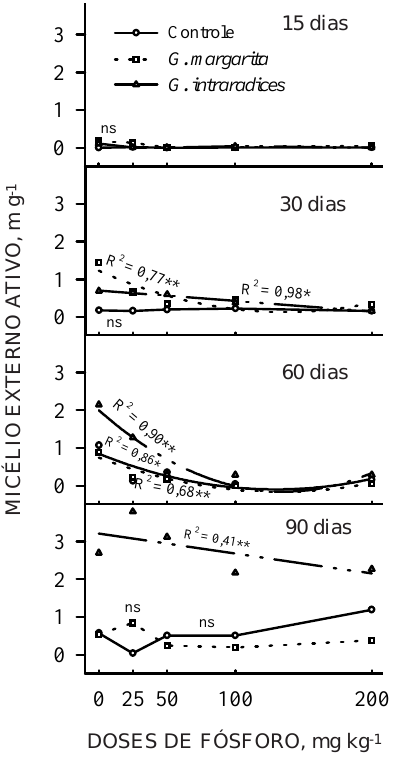
Figura 2. Estimativa do comprimento de micélio externo ativo em substrato cultivado com soja inoculada com fungos micorrízicos arbusculares ( G. margarita ou G. intraradices ) ou não inoculada (Controle), aos 15, 30, 60 e 90 dias do transplantio, considerando as doses de P. * Modelos matemáticos de regressão significa- tivos a 5%; ** = significativos a 1%; ns = não- significativos pelo teste